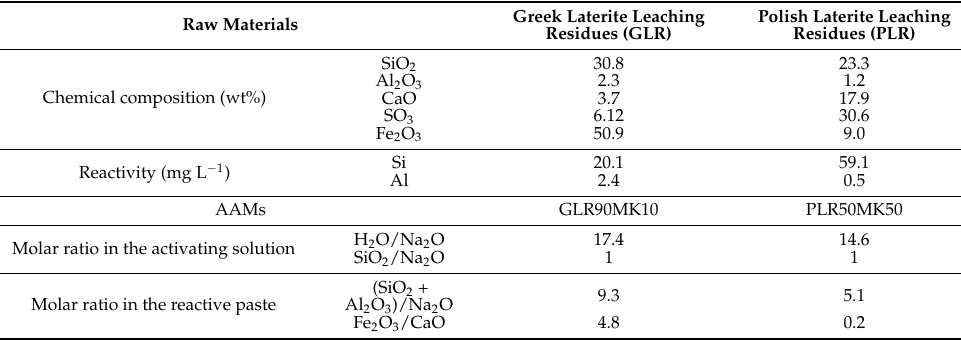
Table 8. Comparison of alkali activation of two laterite leaching